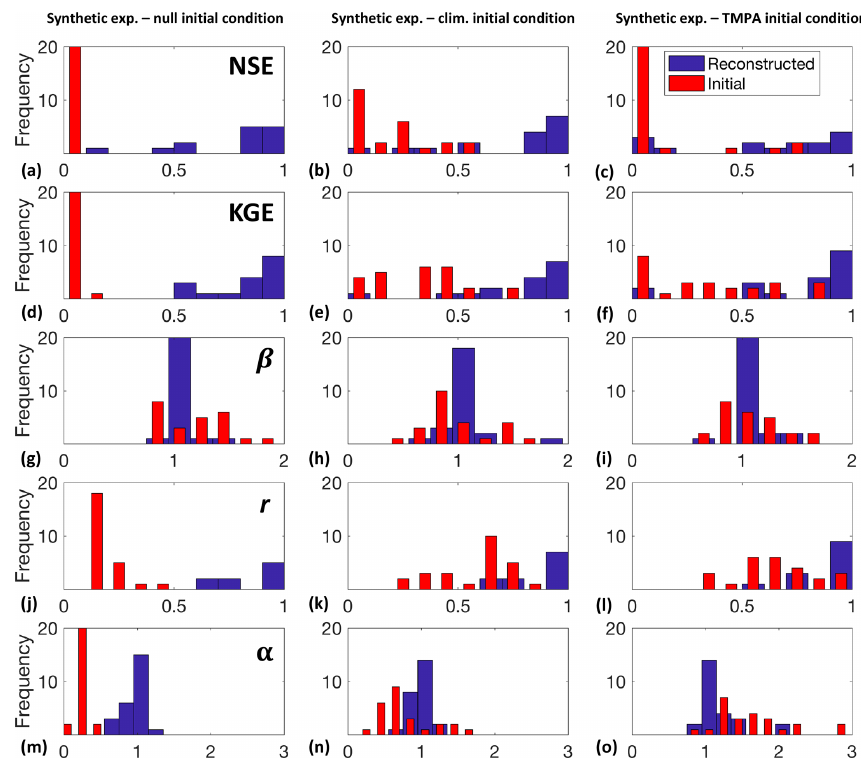
Figure 5. Distributions of NSE values (a, b, c) , KGE values (d, e, f) , and its component statistics: bias ratio β (g, h, i) , correlation coefficient r (j, k, l) , and relative variability α (m, n, o) , for the three synthetic experiments with varied initial conditions of runoff (shown in three columns). These daily initial conditions are (1) null (uniform mean runoff over the entire basin), (2) climatology (average daily runoff over the entire period from NLDAS), and (3) TMPA (runoff derived from TMPA precipitation and VIC LSM). In each plot, the red bars illustrate the distribution of the statistic values for discharge generated from the initial guess of runoff and the blue bars indicate the same distribution after reconstruction with the inverse routing method.